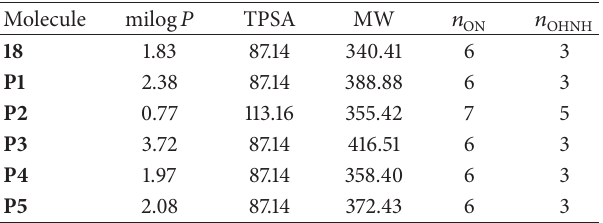
Table 4: Calculated parameters of the Lipinski rule of five for the proposed compounds and compound 18